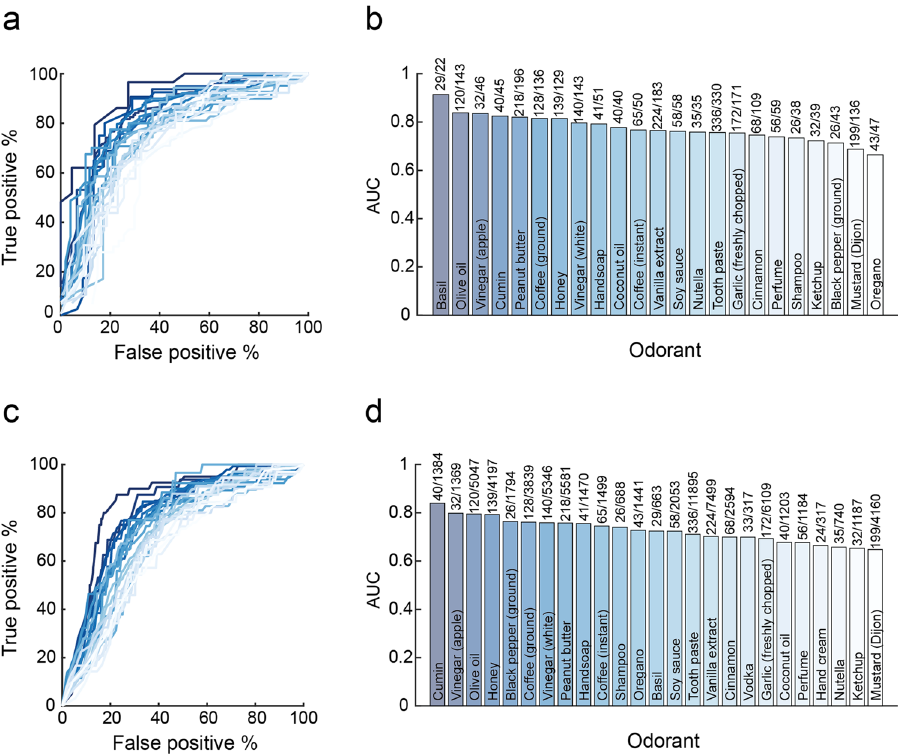
Fig. 4 Single odorant intensity estimates indicate on COVID-19 at the individual level. a Receiver-operator curves (ROCs) based on intensity estimates of 23 odorants obtained from C19 + vs. C19 − participants. b The area under the curve (AUC) for each odorant, with the number of C19 + /C19 − participants above each bar. We note that these bars re fl ect a single value, the AUC of all available data, which has no error associated with it. c ROCs based on intensity estimates of 23 odorants obtained from C19 + vs. C19 − and C19-UD combined participants. d The AUC for each odorant, with the number of C19 + /C19 − and C19-UD participants above each